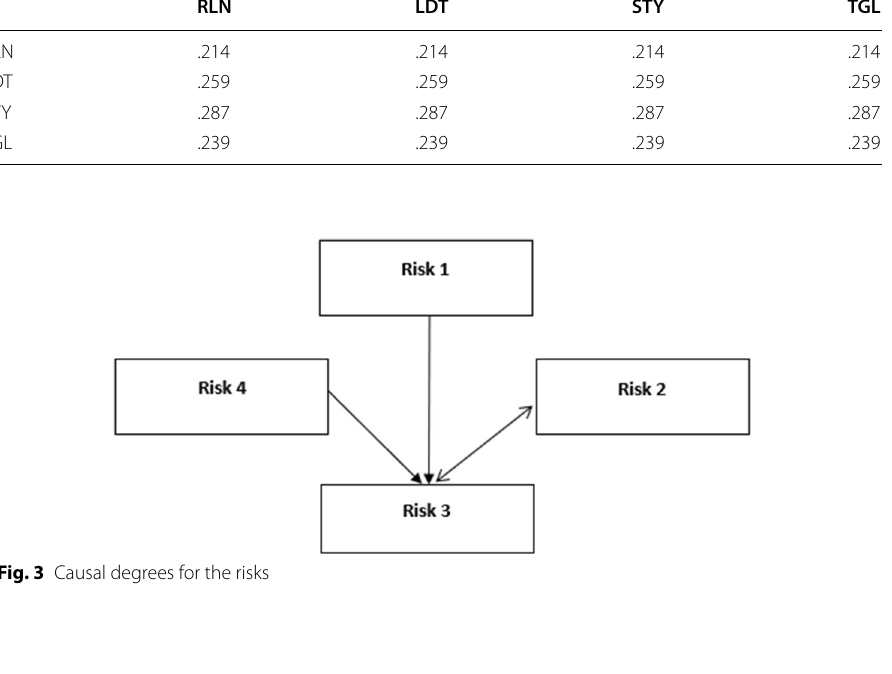
Table 9 Weighting priorities for the